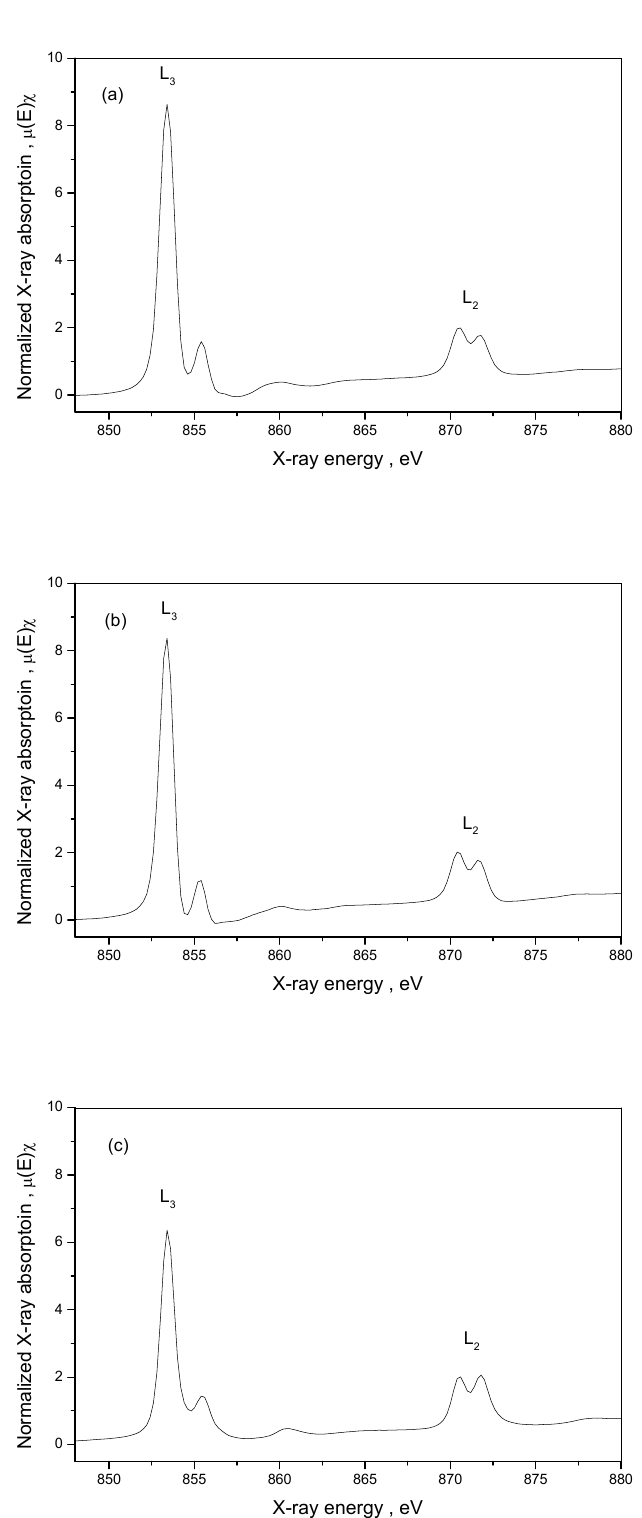
Figure 9. Normalized Ni L-edge absorption spectra for [{Cu(pn) 2 } 2 Ni(NCS) 6 ] n · 2nH 2 O ( 1 ) ( a ), [{Cu II (trien)} 2 Ni(NCS) 6 Cu I (NCS)] n ( 2 ) ( b ) and [Cu(tren)(NCS)] 4 [Ni(NCS) 6 ] ( 3 ) ( c ).